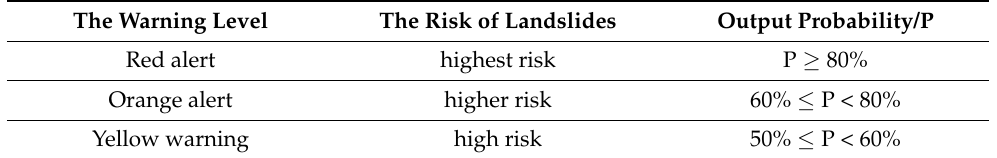
Table 4. Division of early-warning levels.